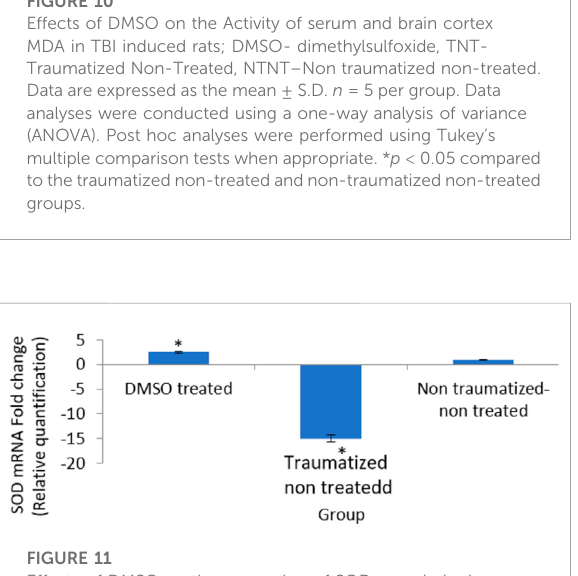
FIGURE 11 Effects of DMSO on the expression of SOD gene in brain cortex of TBI rats by relative quanti fi cation; DMSO- dimethylsulfoxide, TNT- Traumatized Non-Treated, NTNT – Non traumatized non-treated. Data are expressed as the mean ± S.D. n = 5 per group. Data analyses were conducted using a one- way analysis of variance (ANOVA). Post hoc analyses were performed using Tukey ’ s multiple comparison tests when appropriate. * p < 0.05 compared to the traumatized non-treated and non-traumatized non-treated